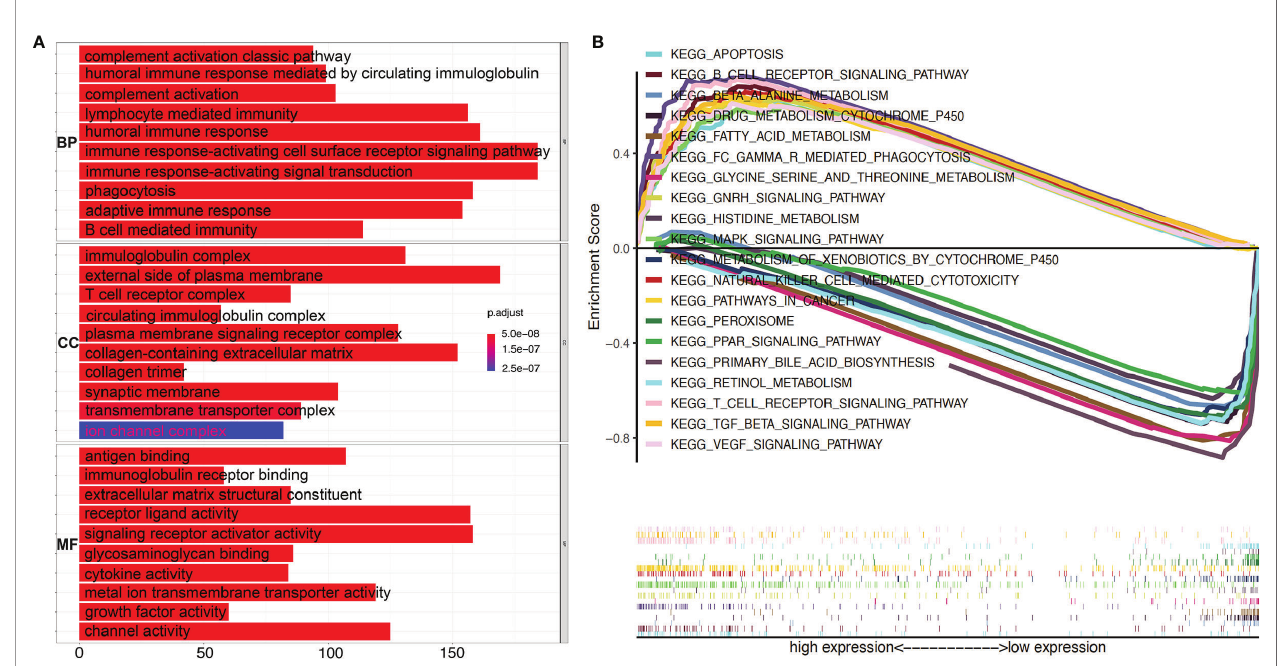
FIGURE 6 | High TGF- b 1 expression is positively correlated with active immunity in HCC patients. (A) GO (Gene Ontology) analyses using e1071, Parallel, and Preprocesscore packages revealed the involvement of TGF- b 1 in activation of various immune-related signal pathways. BP, biological process; CC, cellular component; MF, molecular function. (B) Top ten activated and top ten suppressed signal pathways by high TGF- b 1 level were presented, respectively, using Gene Set Enrichment Analysis (GSEA) software and KEGG